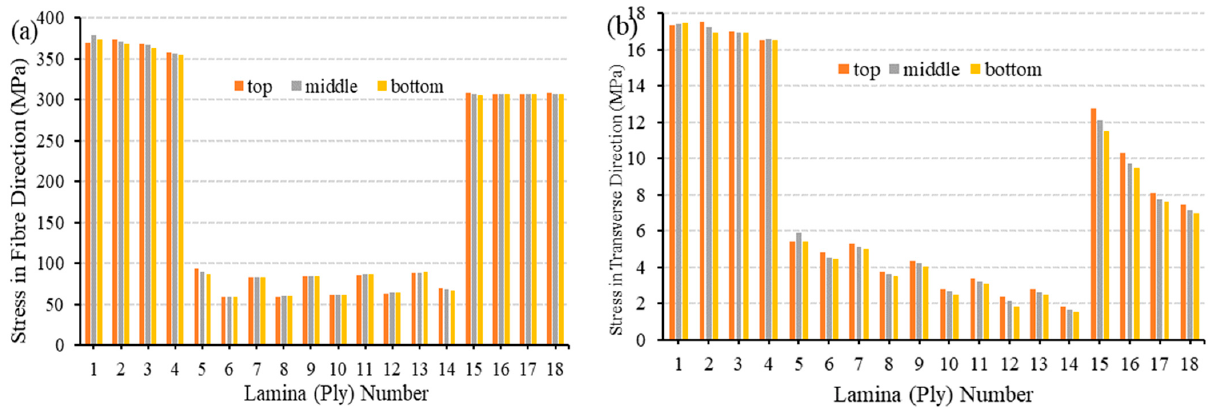
Figure 16. Stress profiles for the top, middle, and bottom lamina along the ( a ) fibre and ( b ) transverse directions under tension and external pressure case. Table 11. Riser deformation and liner stress during tension cum external pressure event’s preliminary